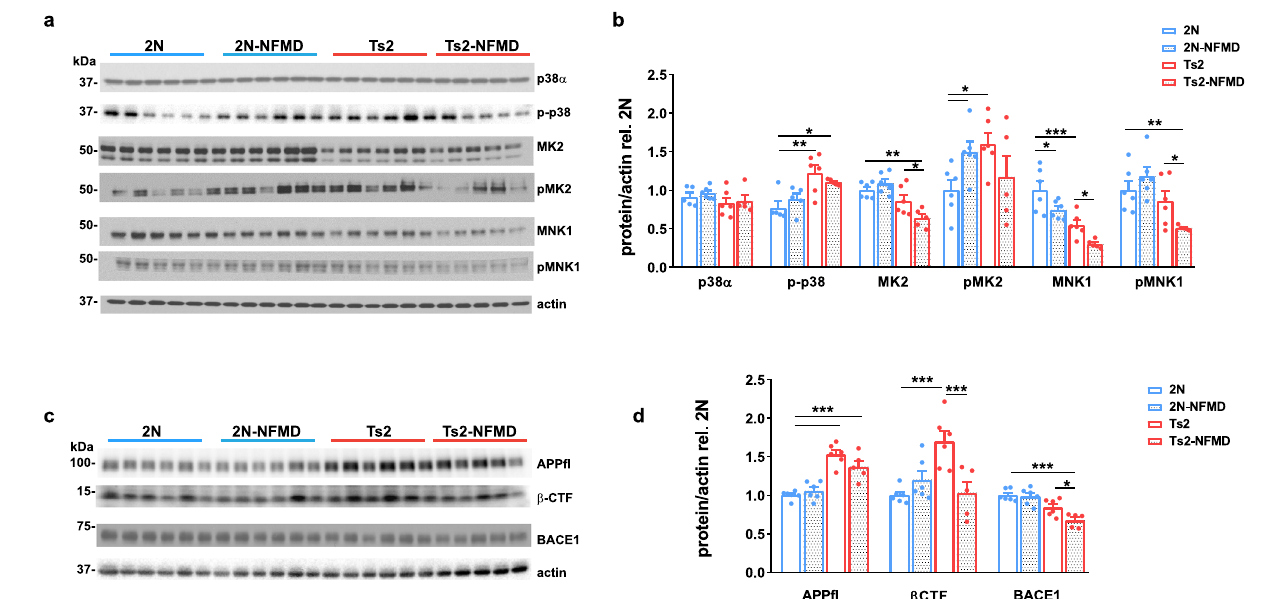
Fig. 3 | Thepositive effects ofne fl amapimod onpathology and function in Ts2 mice appear to be mediated by inhibition of the p38 α kinase pathway and related to BACE1 and β CTF reductions. a Western blot analysis of p38 α , phosphorylated-p38 (p-p38), and downstream substrates MK2 and MNK1 in tissue homogenatesofthebraincortexafter2weeksofeithervehicleorNFMDtreatment ( n =5 for Ts2-NFMD, and n =6 forother treatment groups). b Quanti fi cation of the western blot images shown with Image J and graphed with GraphPad Prism 8.0.1 [Ordinary One-Way ANOVA, For p-p38 F(3, 19)=6.658, R square=0.540, for 2N vs Ts2, p =0.0044, 95% CI= − 0.760, − 0.131; for 2N vs Ts2-NFMD p =0.0495, 95% CI= − 0.656 − 0.000194; For MK2 F(3, 19)=10.33, R square=0.610, for 2N vs Ts2- NFMD, p =0.0005, 95% CI=0.182, 0.541; for Ts2 vs Ts2-NFMD p =0.0166, 95% CI=0.0457, 0.404; For pMK2 F(3, 19)=2.850, R square=0.310, for 2N vs Ts2, p =0.0178,95%CI= − 1.095, − 0.117;for2Nvs2N-NFMD p =0.0469,95%CI= − 0.985, − 0.0076; for Ts2 vs Ts2-NFMD p =0.0166, 95% CI=0.0457, 0.404; For MNK1 F(3, 19)=15.11,Rsquare=0.705,for2NvsTs2, p =0.0003,95%CI=0.235,0.668;for2N